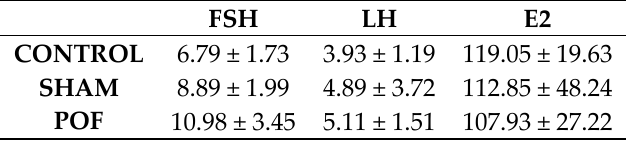
Table 1. Serum concentration level of FSH, LH and E2 of C, S and POF groups (Mean ±